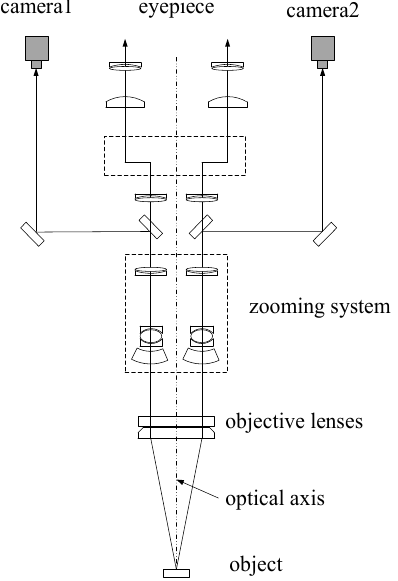
Figure 3. Schematic diagram of the light path of a common main objective-stereo light microscope (COM-SLM; ref. [34], Figure 1).